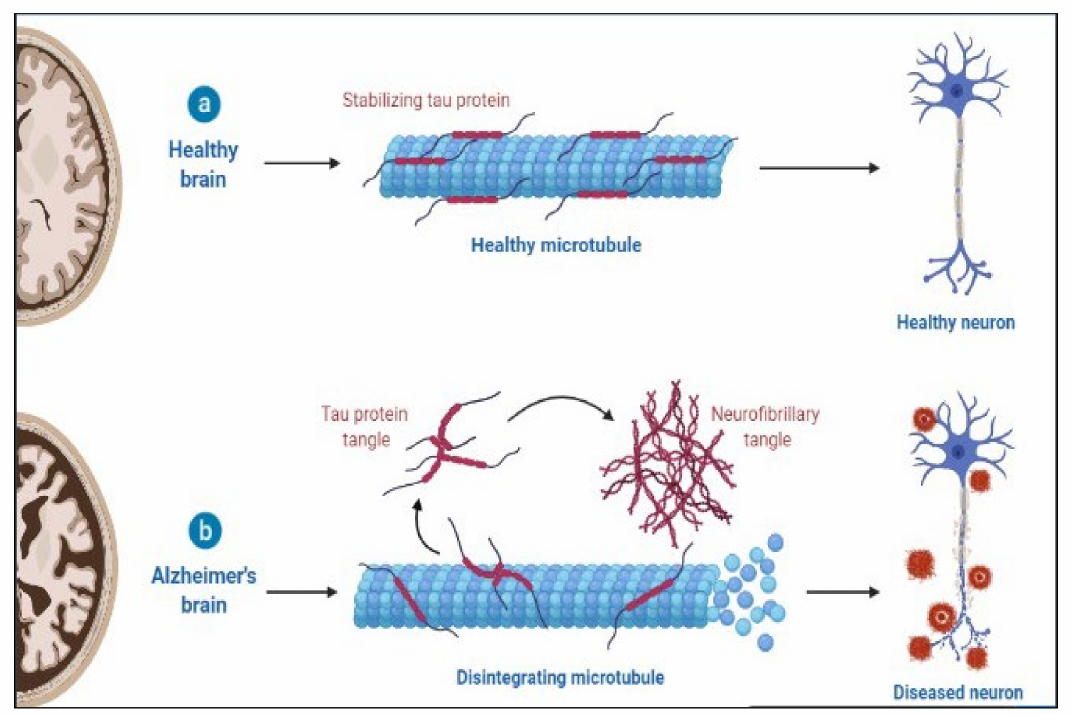
Figure 2. Pathology of